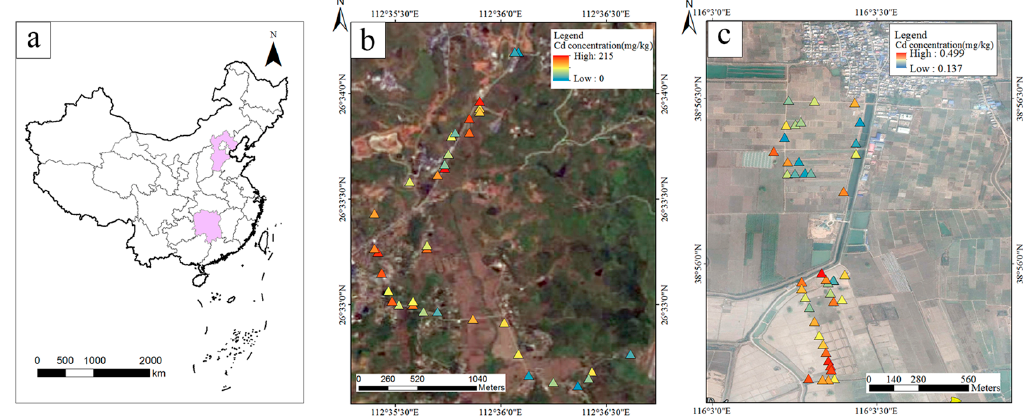
Figure 2. ( a ) Two case areas located in the painted province of China. ( b , c ) are the locations of soil sampling sites in Hengyang and Baoding, respectively.